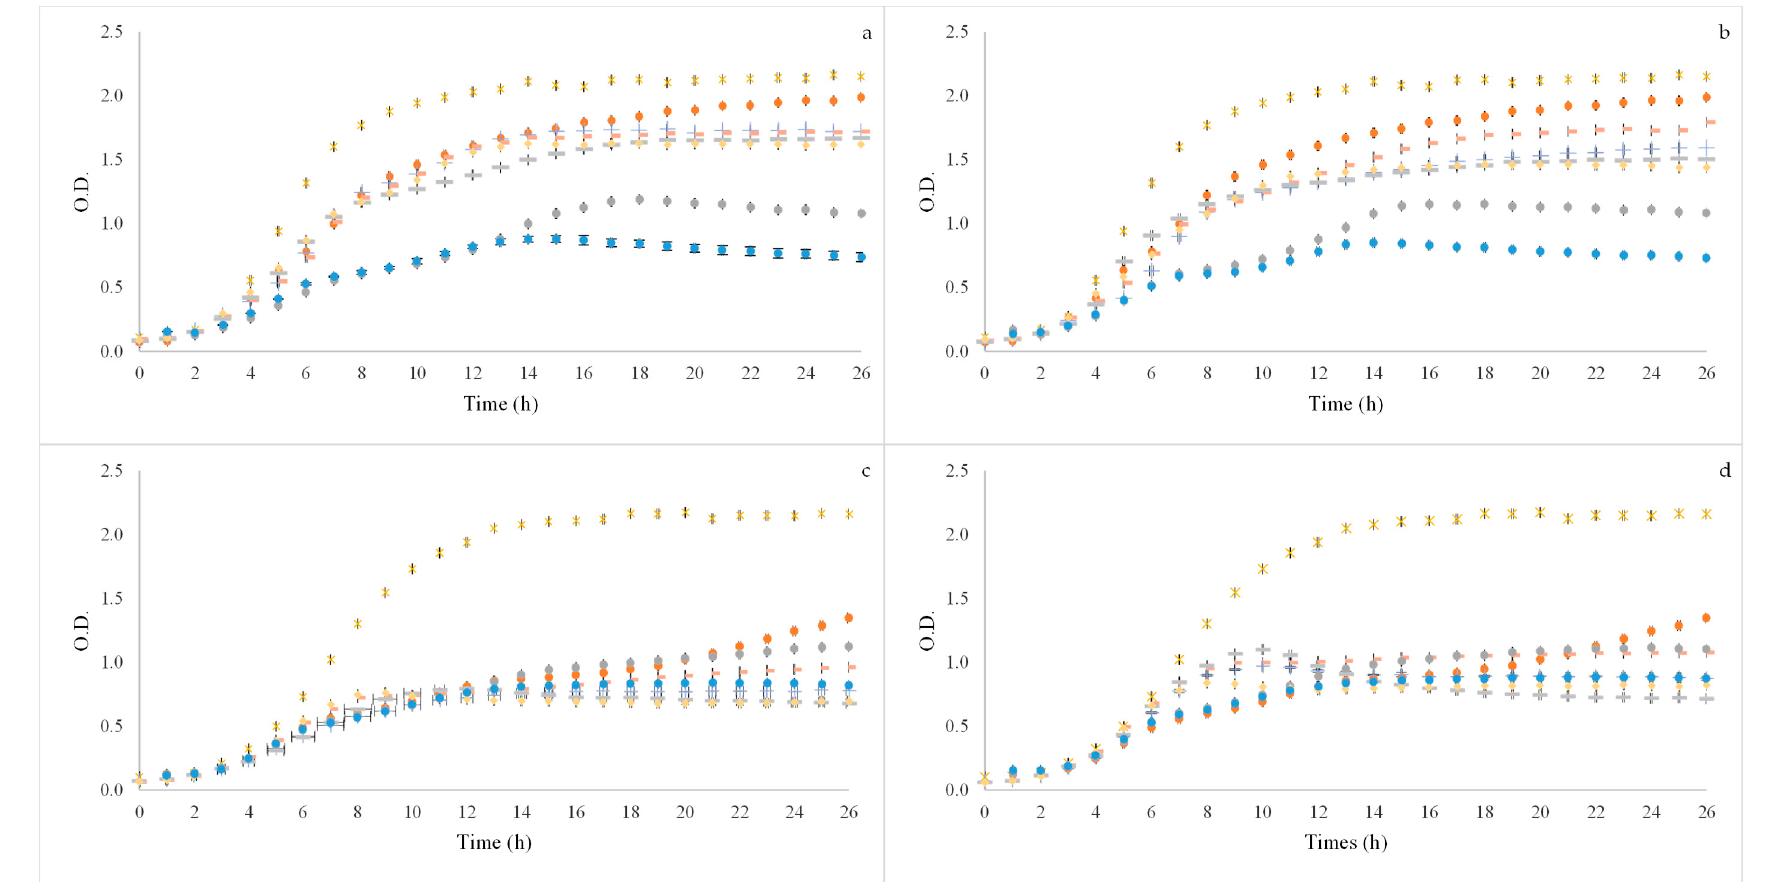
Figure 3. Growth curves of probiotic microorganisms Lacticaseibacillus casei 01 ( a , b ) and Lactobacillus acidophilus LA-5 ( c , d ) after applying BSG flours of SLE ( a , c ) and OHE ( b , d ) using three concentrations (2, 1.5 and 1% ( v/w )). x Positive control—Glucose; • Positive control—FOS; + 60% ethanol:water SLE or OHE_2% ( v/w ); - 60% ethanol:water SLE or OHE_1.5% ( v/w ); • 60% ethanol:water SLE or OHE_1% ( v/w ); - 80% ethanol:water SLE or OHE_2% ( v/w ); ⧫ 80% ethanol:water SLE or OHE_1.5% ( v/w ); • 80% ethanol:water SLE or OHE_1% ( v/w ). 80% ethanol:water SLE or